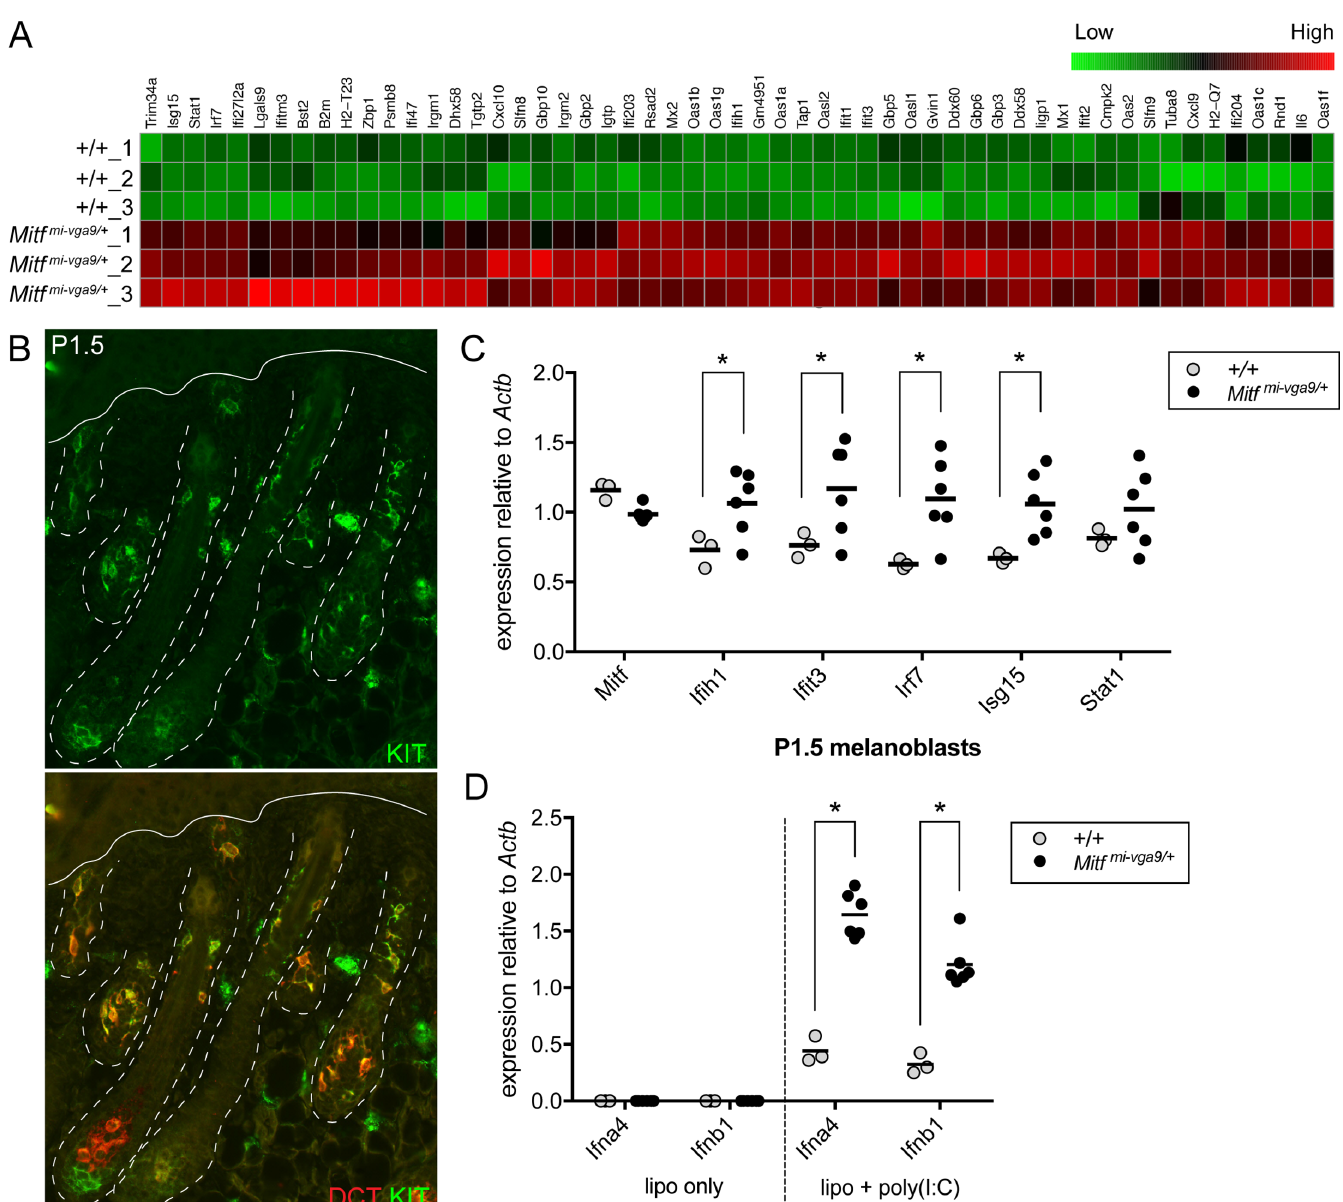
Fig 3. Mitf mi-vga9/+ McSCs and melanoblasts exhibit an elevated type I interferon gene expression signature and Mitf mi-vga9/+ melanoblasts show increased sensitivity to viral mimic. (A) Heatmap of scaled and clustered, rlog-transformed read count values obtained from RNA-seq analysis of Mitf mi-vga9/+ and wild-type McSCs. Fifty-five of the four hundred eleven genes that demonstrated a statistically significant, greater than 1.5-fold increase in expression in Mitf mi-vga9/+ McSCs over wild-type McSCs participate in innate immune signaling and are presented here ( p adjusted < 0.05, Benjamini-Hochberg adjusted p -value). (B) Immunolabeling for KIT protein in mouse skin at P1.5. At this time point, KIT+ (green), DCT+ (red) melanoblasts are observed migrating into the developing hair follicles. The dotted white lines outline the hair follicles and the solid line indicates the position of the epidermis. (C) qRT-PCR analysis of Mitf and ISG expression ( Ifih1 , Ifit3 , Irf7 , Isg15 , and Stat1 ) in primary melanoblasts isolated from Mitf mi-vga9/+ and wild-type littermate pups at P1.5. Each circle indicates the expression of cells from an individual primary melanoblast cell line generated from an individual pup. The horizontal bars represent the mean, and the asterisks indicate gene expression changes with a q -valueof < 0.05 using the two-stage linear step-up procedure of Benjamini, Krieger, and Yekutieli, with Q = 5%. (D) qRT-PCR analysis of type I interferon gene expression ( Ifna4 and Ifnb1 ) in primary melanoblast cell lines (isolated as described in [C]). Melanoblast cell lines were treated for 9 hours with lipofectamine only (lipo only) or lipofectamine and poly(I:C) (lipo + poly(I:C)). The horizontal bars represent the mean, and the asterisks indicate gene expression changes with a q -valueof < 0.05 using the two-stage linear step-up procedure of Benjamini, Krieger, and Yekutieli, with Q = 5%. The data presented here are representative of two independent experiments testing poly(I:C) treatment of primary melanoblast cell lines at two different cell passages. The raw data used to generate the graphs in (C) and (D) are available in S1 Data.DCT, dopachrome tautomerase; ISG, IFN-stimulated gene; lipo + poly(I:C), lipofectamine and poly(I:C); lipo only, lipofectamine only; Mitf , melanogenesis associated transcription factor; McSC, melanocyte stem cell; P, postnatal day; qRT-PCR, quantitative reverse transcriptase polymerase chain reaction; RNA-seq, RNA sequencing.